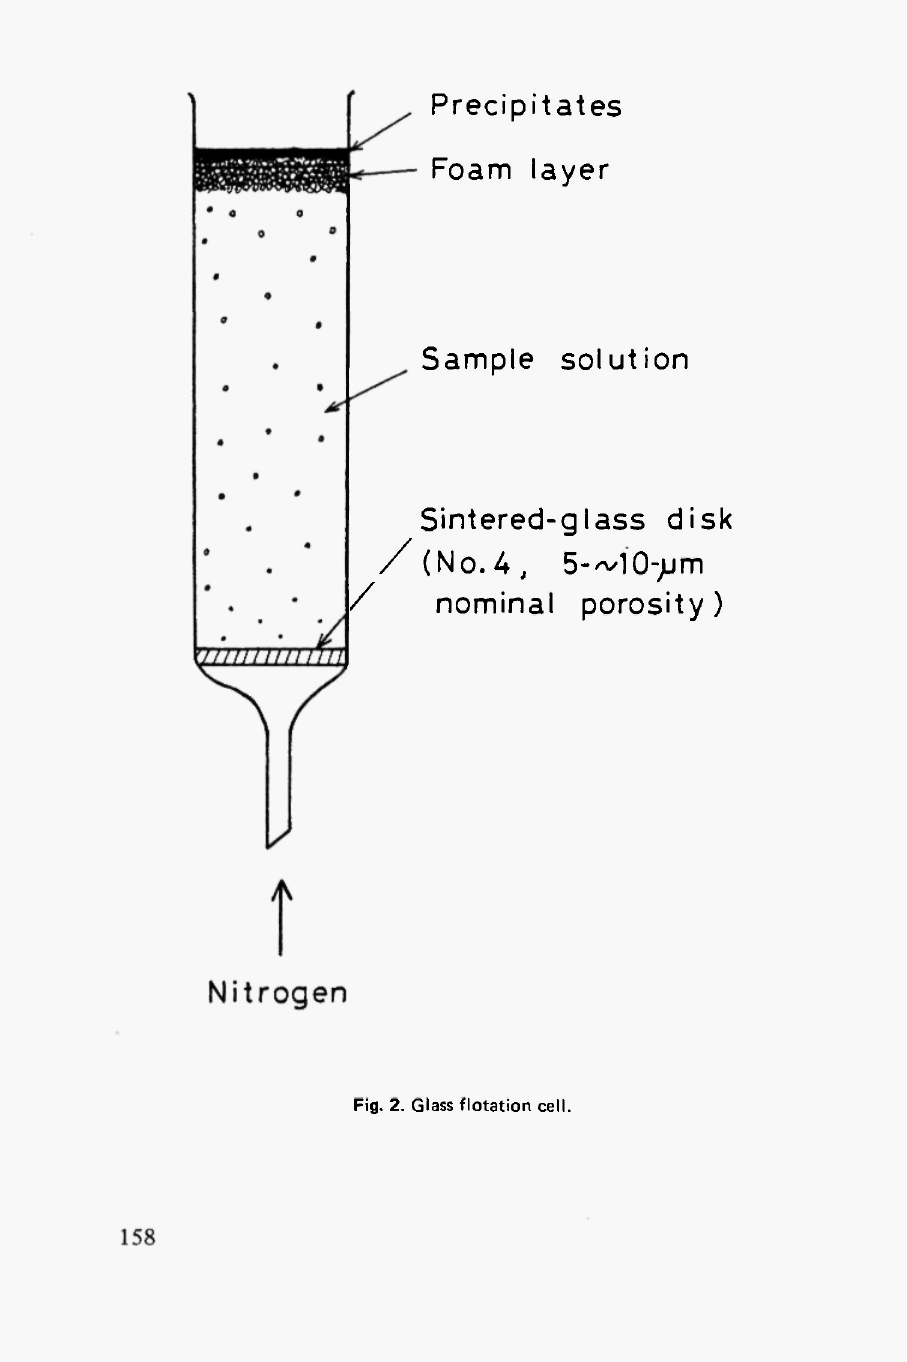
Fig. 2. Glass flotation